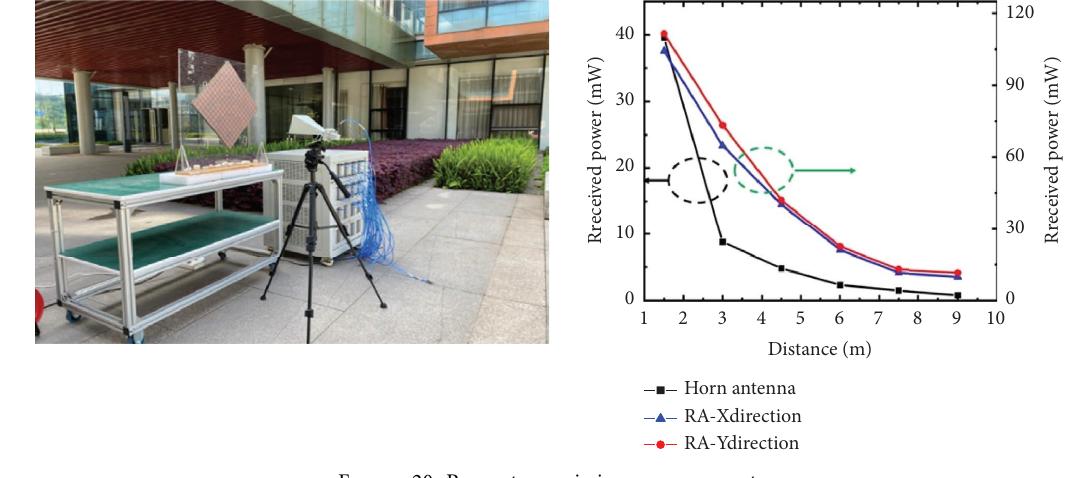
RA-YdirectionRA-Xdirection